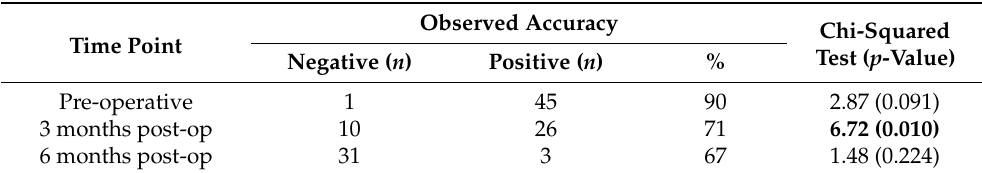
Table 2. Observed accuracy (Jobe vs. IRO/Shift) depending on examination points for the injured sample ( n =